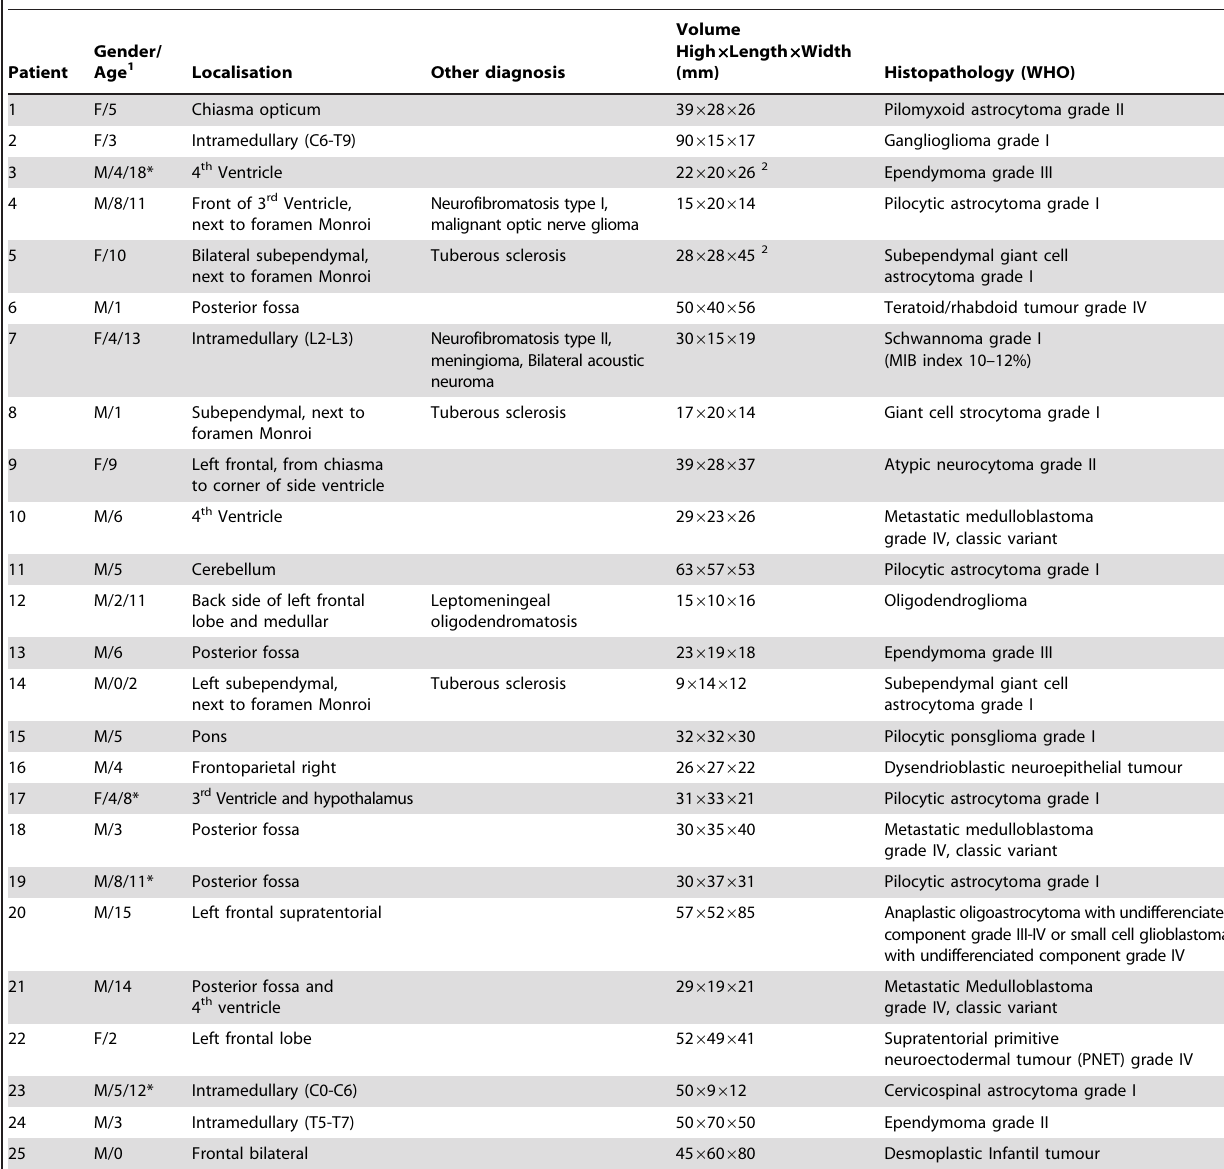
Table 1. Characteristics of patients and their CNS tumours.